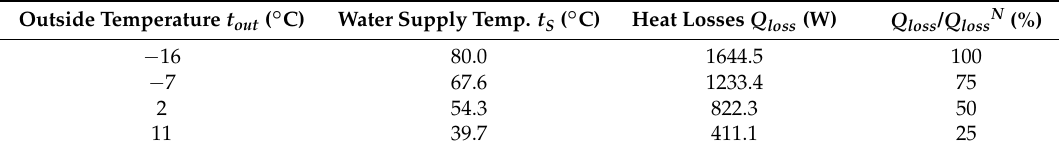
Table 4. Boundary conditions, supply water temperature, and losses.